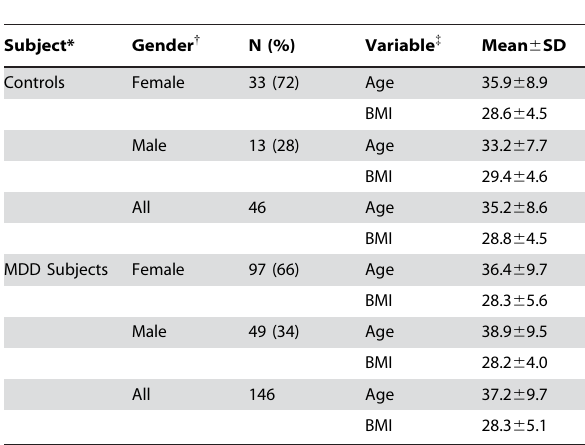
Table 1. Demographic Data and BMI for Controls and MDD